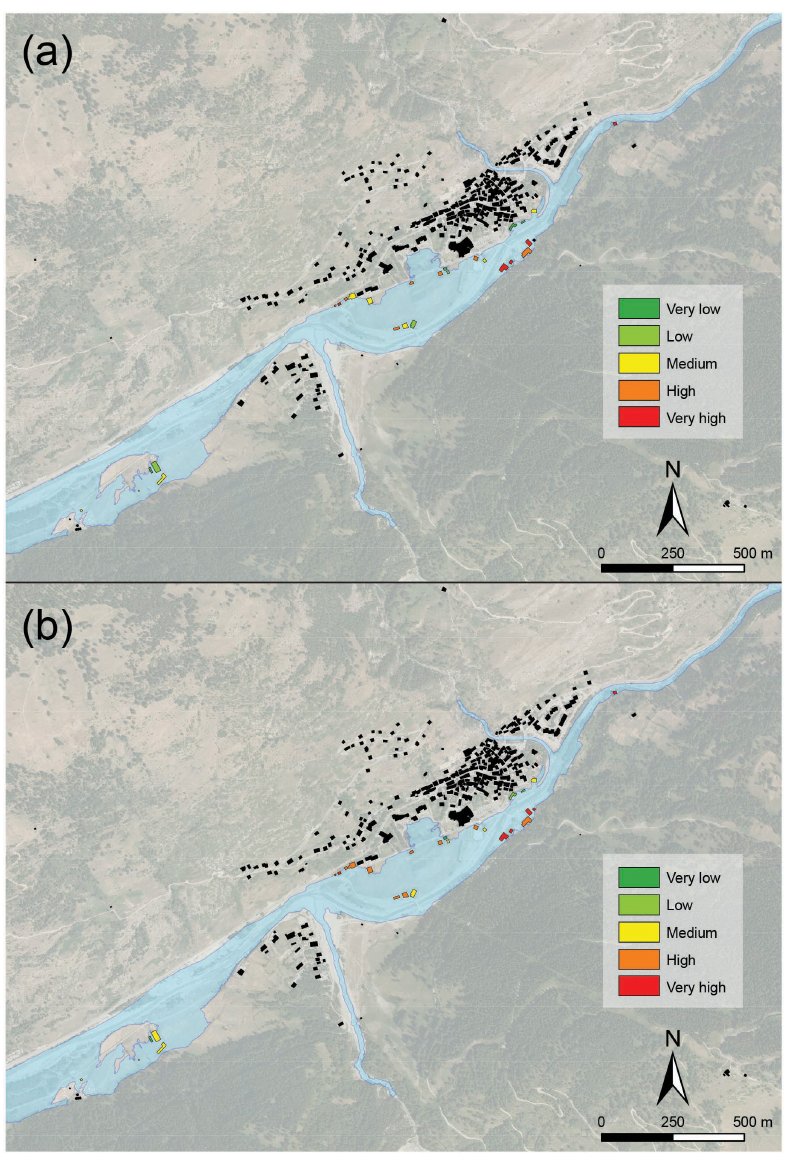
Figure 7. Comparison between type 1957 flood risk maps produced using PDI and those using PCI. (a) Flood risk map produced using PDI. (b) Flood risk map produced using